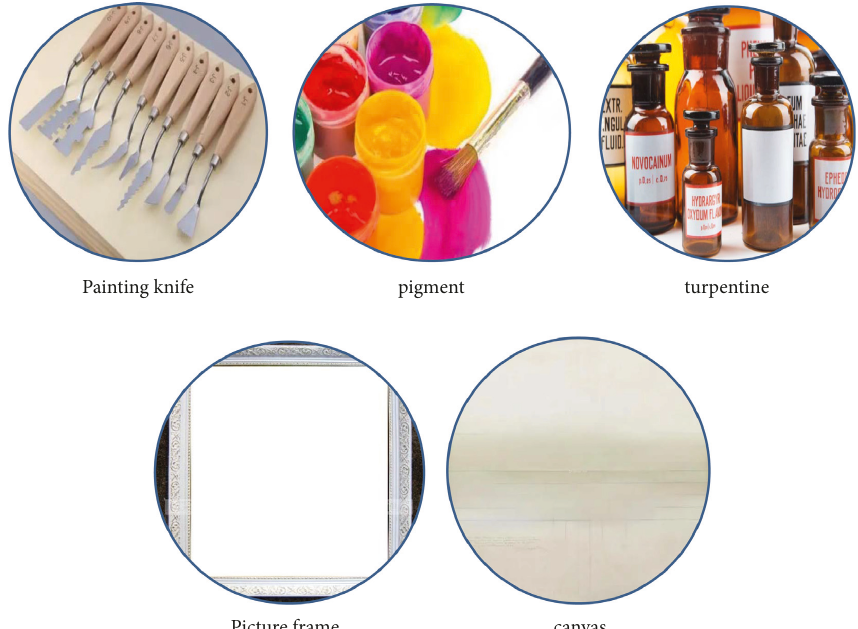
Figure 1: Common oil painting